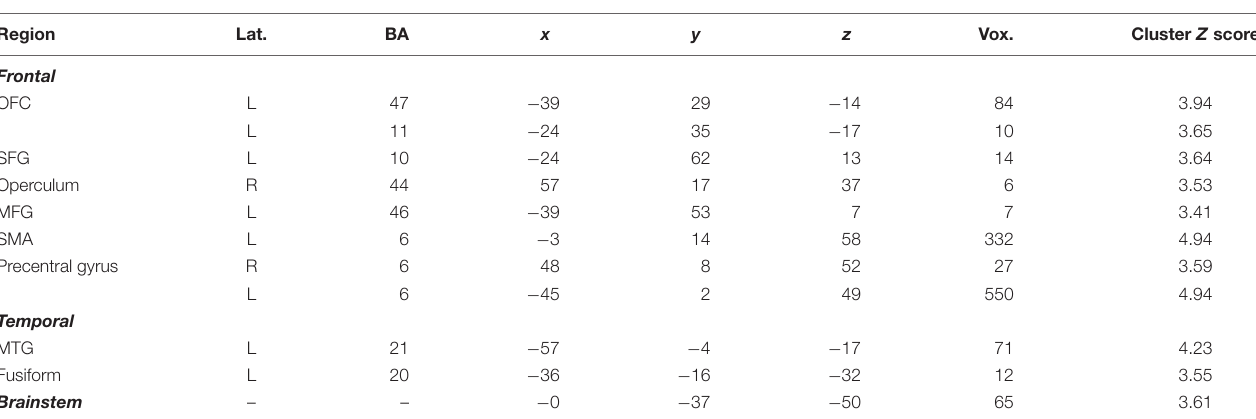
TABLE 5 | Minor clusters activated during the memory substitution vs. no-think2 contrast. Region